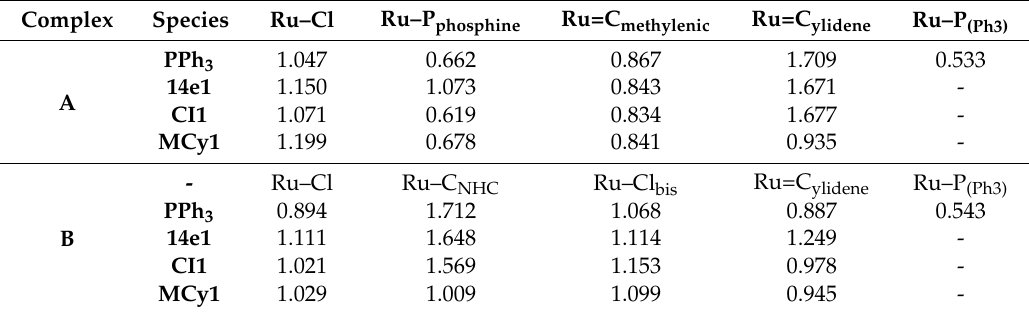
Table 3. Mayer bond orders for complexes A and B (in Å).